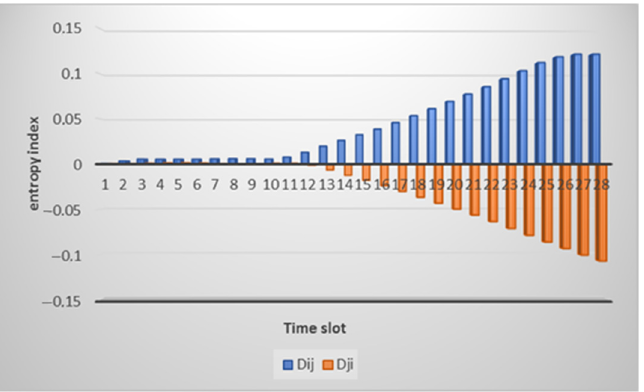
Figure 7. The result of calculating the entropy for: ( a ) received packets; and ( b ) sent packets by node i relative to node j (marked in blue) and by node j relative to node i (marked in orange) with additional payload.